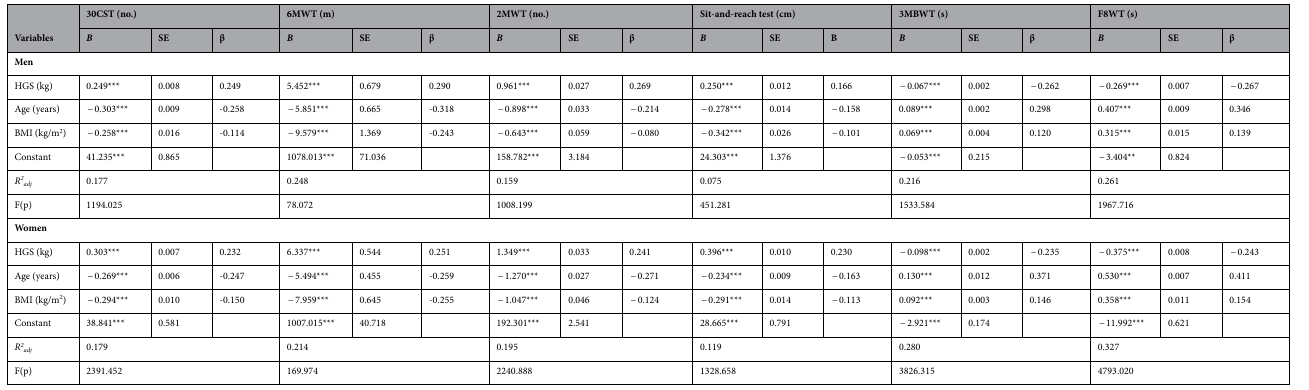
Table 3. Association of physical fitness parameters with hand grip strength. BMI body mass index, HGS hand grip strength, 30CST 30-s chair stand test, 6MWT 6-min walk test, 2MWT 2-min walk test, 3MBWT 3-m backwards walk test, F8WT figure-of-8 walk test, B unstandardized regression coefficient, SE standard error, β standardized regression coefficient, R 2 adj coefficient of determination. ***P < 0.001 through multiple linear regression